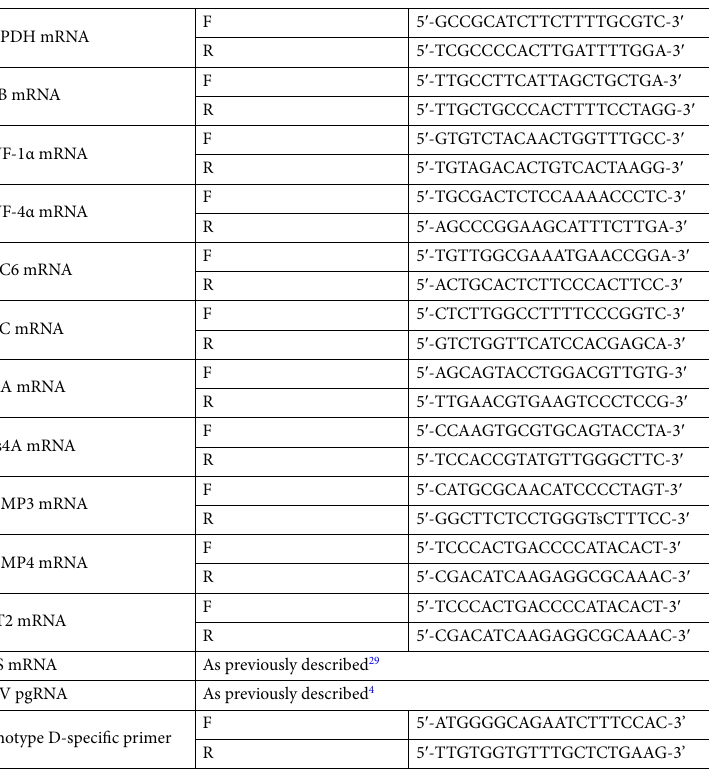
Table 1. The sequence of target-specific primer sets (F, forward primer; R, reverse